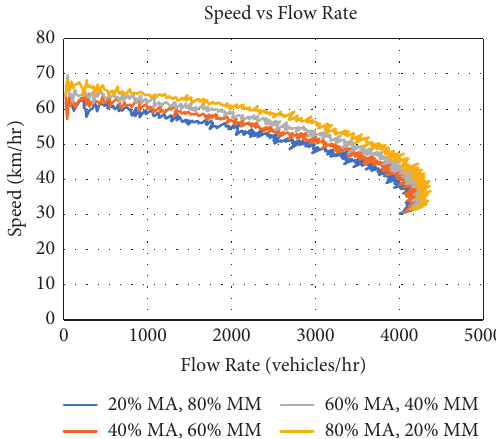
Figure 28: Speed vs. flow rate fundamental diagrams for different compositions of MA and MM.